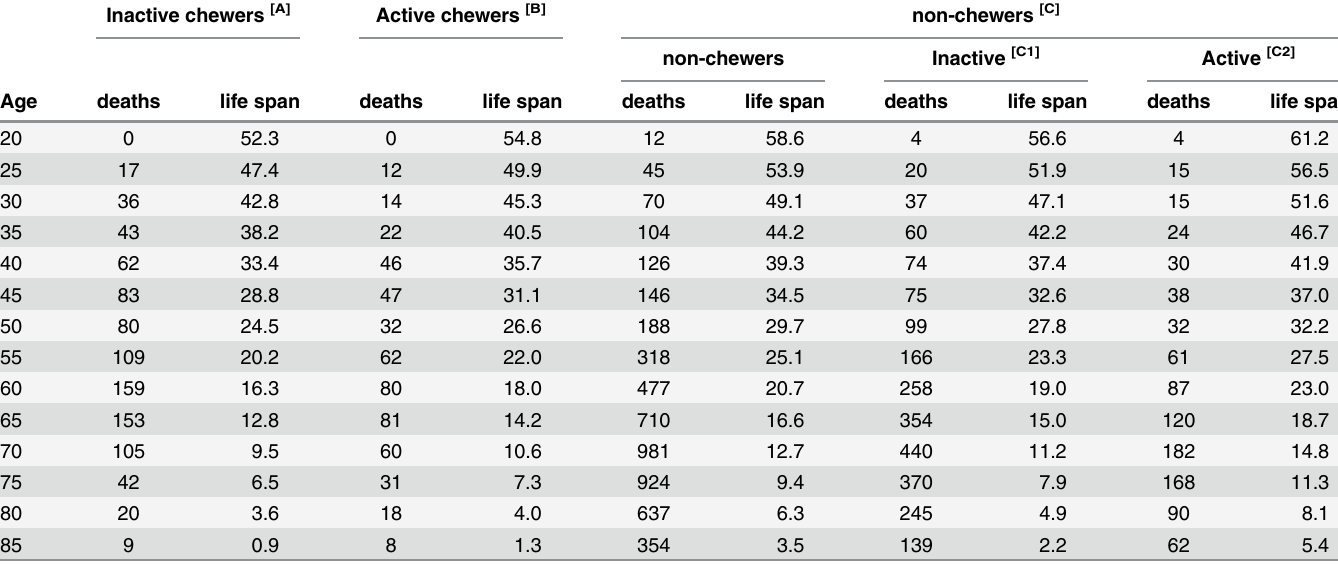
Table 4. Comparison of life expectancy among inactive chewers, active chewers, and general